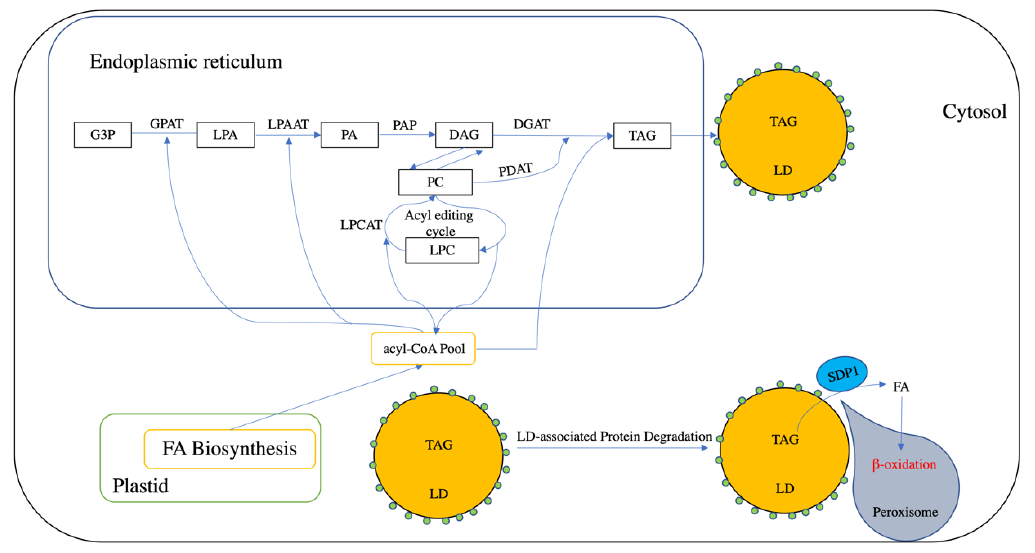
Figure 1. Brief Overview of triacylglycerol (TAG) biosynthesis, storage, and degradation in plants. Plastid provides a fatty acid (FA) pool, which can be transported into cytosol and activate into acyl-CoA. In the endoplasmic reticulum, G3P (glycerol 3-phosphate) can be acylated into lysophosphatidic acid (LPA) at the sn-1 position by using acyl-CoA as an acyl donor. Lyso-phosphatidic acid (LPA) can then be acylated with an acyl moiety from acyl-CoA pool and yield phosphatidic acid (PA) by acyl-CoA:lyso-phosphatidic acid acyltransferase (LPAAT). Phosphatidic acid phosphatase (PAP) is responsibleforthedephosphorylationofPAintodiacylglycerol(DAG).DAGcanbedirectlyacylatedinto TAG by diacylglycerol acyltransferase (DGAT). DAG also can be exchanged with phosphatidylcholines (PC). PC also can be generated through the acyl editing cycle, which involves the reacylation–acylation cycle. Additionally, acyl-CoA can be incorporated into PC by lysophosphatidylcholine acyltransferase (LPCAT). PC can be catalyzed by a phospholipid:diacylglycerol acyltransferase (PDAT) into TAG. Lipid droplets (LDs) is an organelle used for TAG storage, which is covered by a single layer of phospholipid- and LD-associated proteins (small green circles). The degradation of LD is initiated with the degradation of LD-associated proteins. Afterwards, peroxisome can interact with the LD and deliver a TAG lipase (sugar-dependent 1, SDP1) into the LD surface and hydrolysis TAG into FA and glycerol with the association of other lipases (not shown in this figure). FA is transported into peroxisome for β